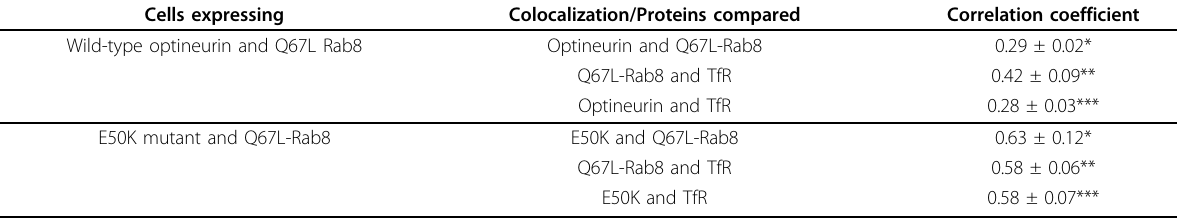
Table 2 Correlation coefficients for pairwise colocalization Cells expressing Colocalization/Proteins compared Correlation coefficient Wild-type optineurin and Q67L